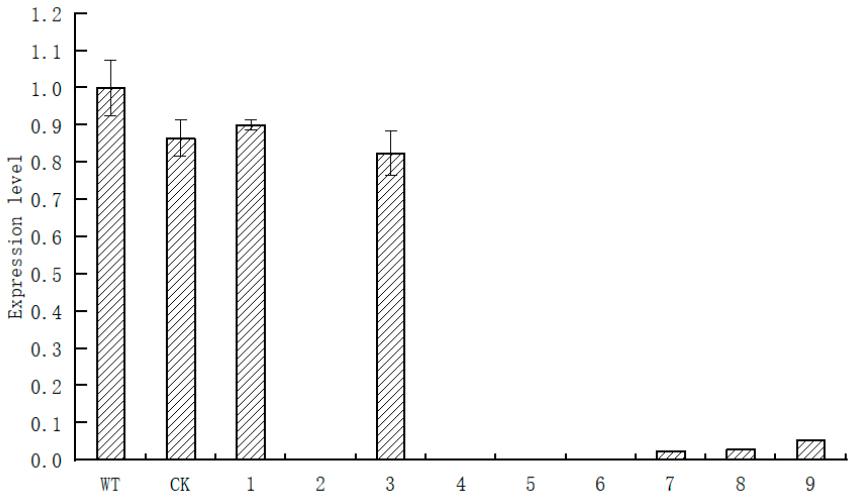
Figure 8. Relative expression of PsARRO − 1 at different treated transgenic Paeonia suffruticosa seed- lings.